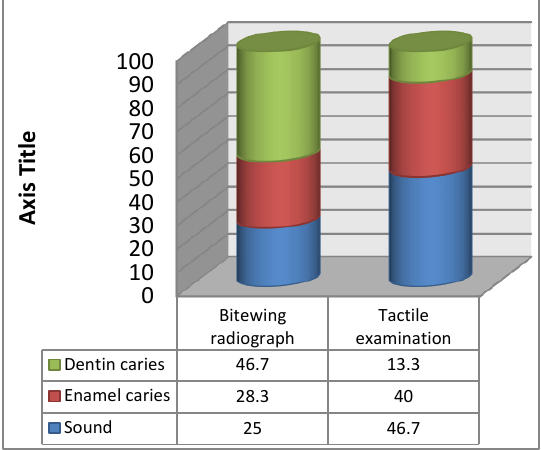
Figure 2: Illustrated percentile value of different threshold of each techniques at proximal